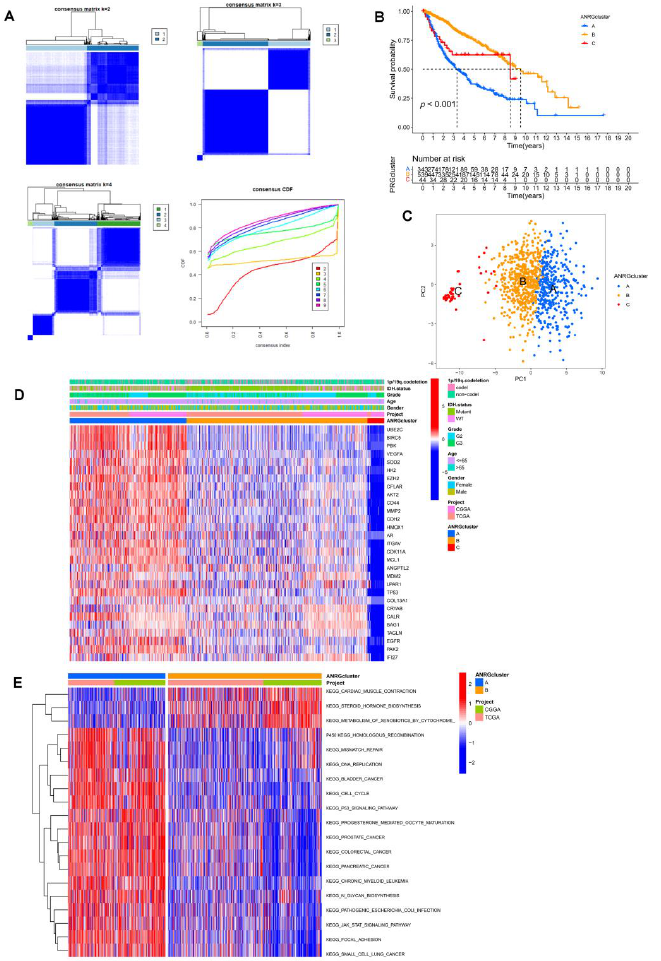
Figure 3. Subgroups of LGGs associated with 29 ANRGs. ( A ) The consensus matrix was obtained by applying consensus clustering when k = 2, 3 and 4. When k = 2, the slope of the CDF curve is the lowest. ( B ) Overall survival of three subtypes ( p < 0.001). ( C ) PCA distinguished three subtypes based on the expression of ANRGs. ( D ) Heat map of the expression of 29 ANRGs and corresponding clinicopathological features of two subtypes. ( E ) GSVA analysis focused on the differential enrich- ment of KEGG pathways between clusters A and